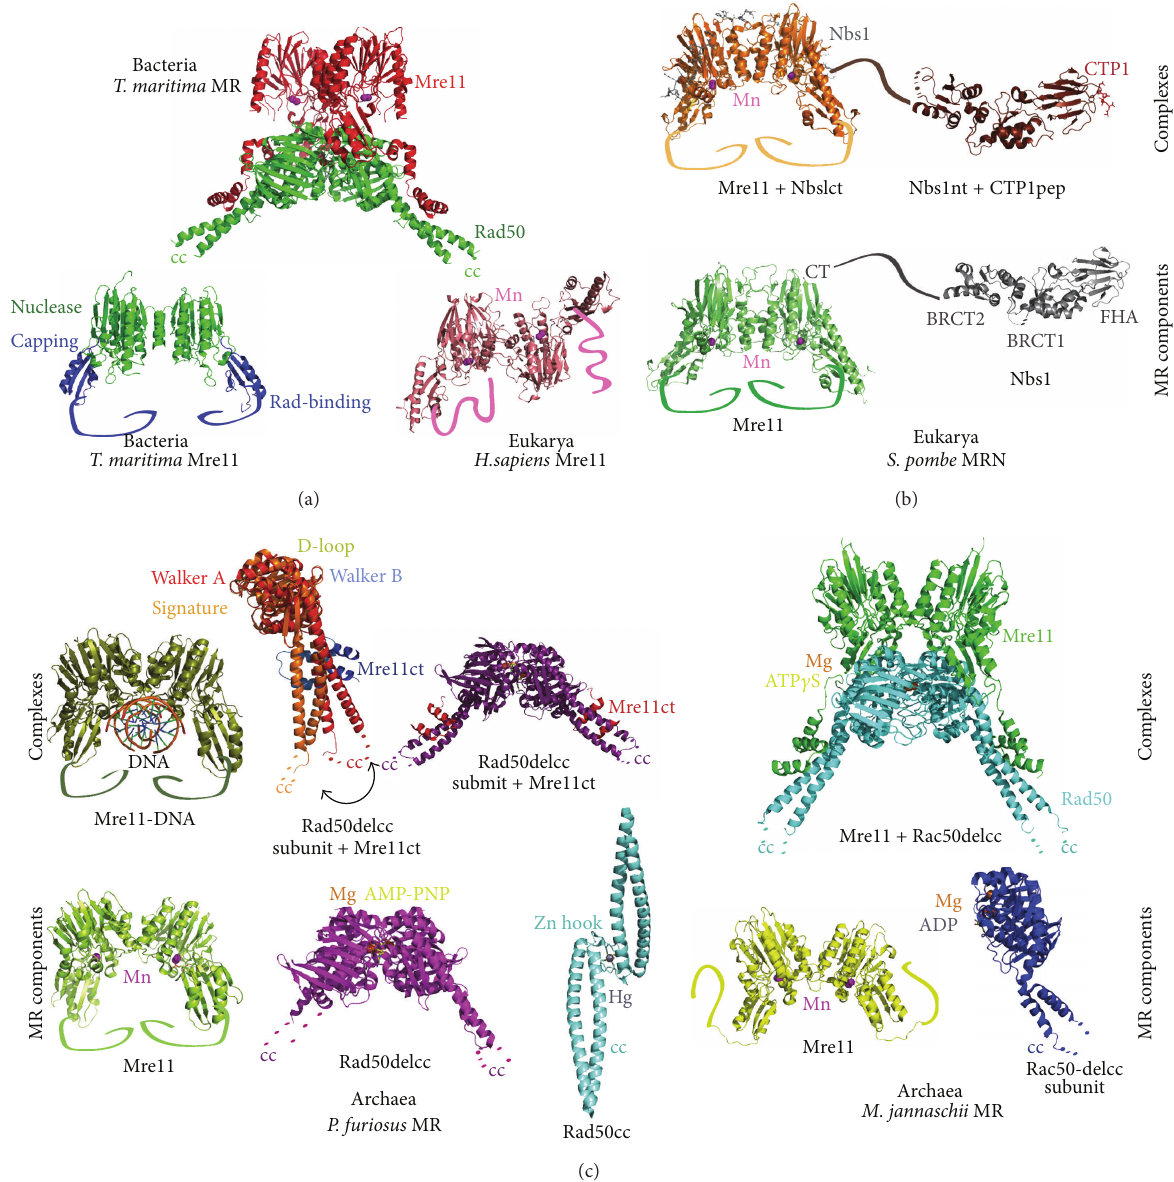
Figure 5: Conservation of MR family members in three domains. (a) Structures of bacterial homologs have elucidated domain organization of MR components. The bacterial Mre11 dimer, exemplified by the T. maritima homolog (PDB code 2Q8U), contains the larger, N-terminal nuclease domains (green), the adjacent capping domains, and Rad-family member binding domains (not structurally defined for TmMre11). The Rad50 portion of the Mre11-Rad50 complex (PDB code 3THO) in T. maritima is comprised of a curved, globular domain of two lobes with intervening coiled coils (lower regions). (b) Human and yeast MRN structures reveal eukaryote-specific features. The subunit orientation of human Mre11 dimer (PDB 3T1I) is substantially rotated, as compared to other known homolog structures. Mre11 and Nbs1 complexes exemplified by S. pombe (PDB codes 4FCX (SpMre11); 4FBW (SpMre11 with SpNbs1 C-terminal region); 3HUE (C-terminally truncated SpNbs1); 3HUF (SpNbs1 in complex with CTP1 peptide)) have revealed key regulatory interactions including the binding site